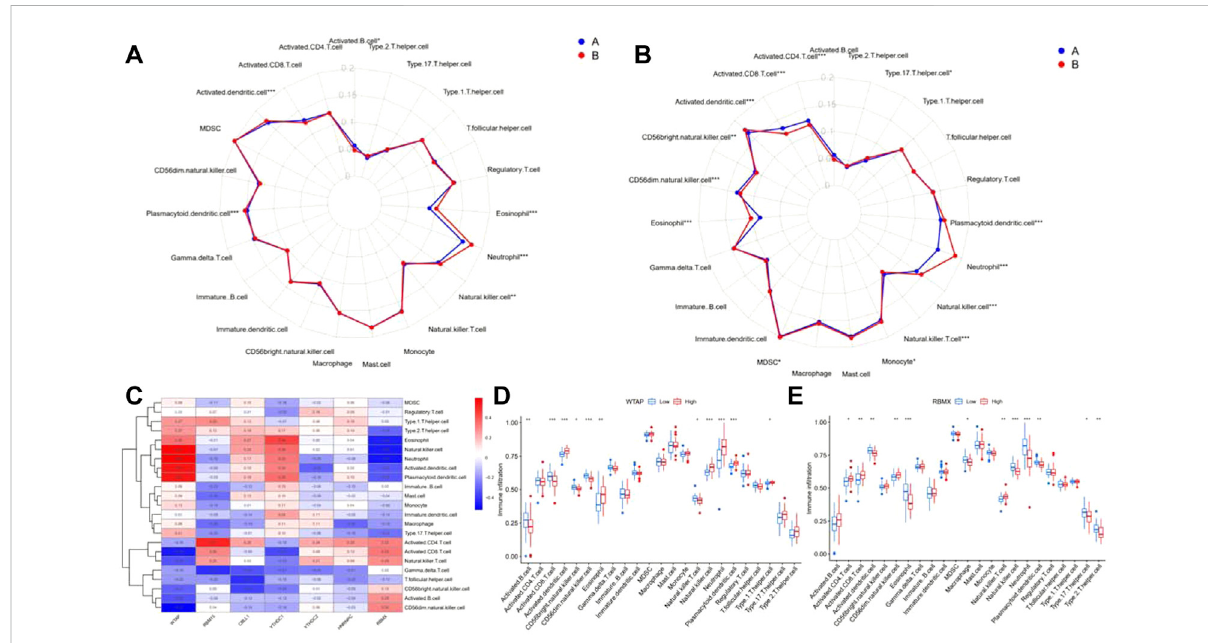
FIGURE 8 Immune characteristics between m6A and gene clusters. (A,B) Radar plot showing the 23 types of immune cells differing between m6A and gene clusters. (C) The correlation between the abundance of immune cells and seven signi fi cant m6A regulators. (D – E) Immune in fi ltration of the differential expression group of RBMX and WTAP. * p < 0.01, ** p < 0.001, *** p < 0.0001.